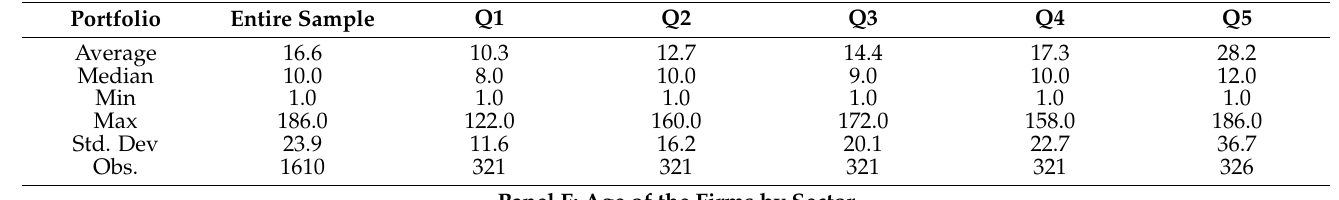
Panel F: Age of the Firms by Sector